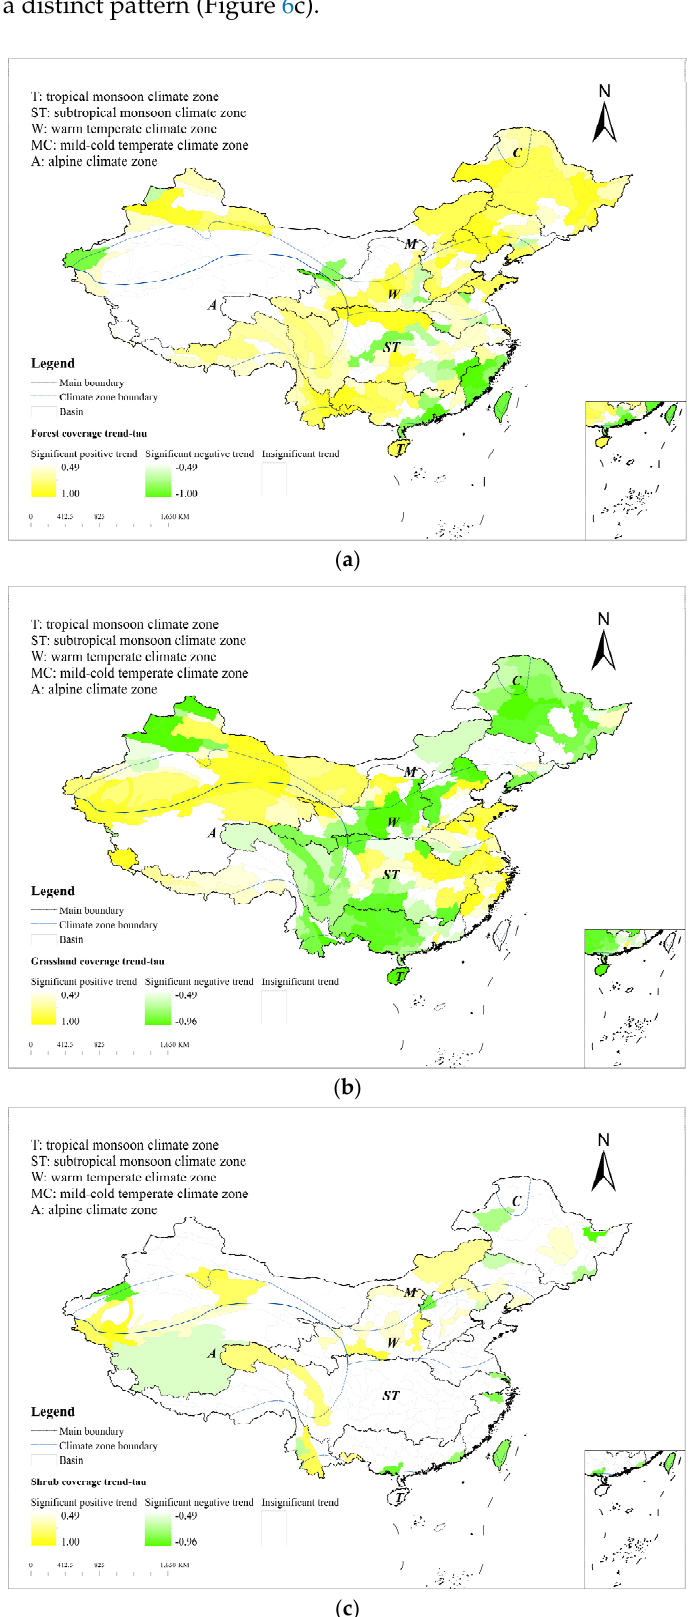
Figure 6. ( a ) Forest coverage trends from 2004 to 2014 in 214 watersheds in China ( p < 0.05); ( b ) grassland coverage trends from 2004 to 2014 in 214 watersheds in China ( p < 0.05); ( c ) shrub coverage trends from 2004 to 2014 in 214 watersheds in China ( p <